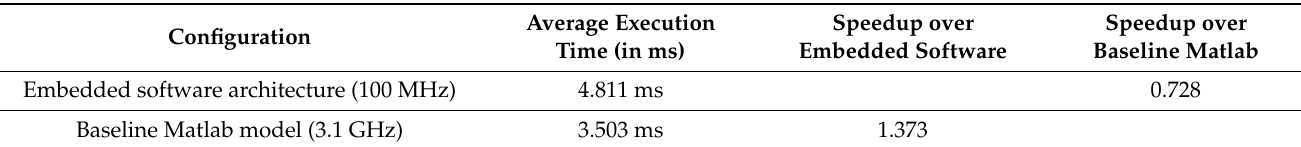
Table 3. Performance comparison: embedded software architecture vs. baseline Matlab model.